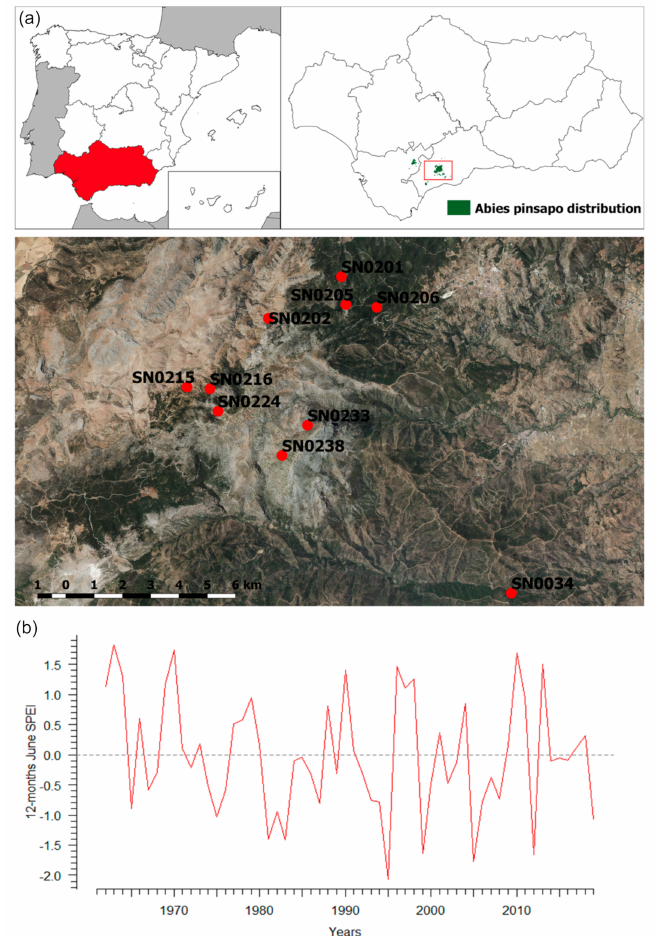
Figure 1. ( a ) Spatial distribution of Abies pinsapo ICP-Forests plots in Sierra de las Nieves (M á laga, South Spain). ( b ) Climate trends considering the Standardized Precipitation Evapotranspiration Index (SPEI) calculated at 12-month-long scales for the 1960–2019